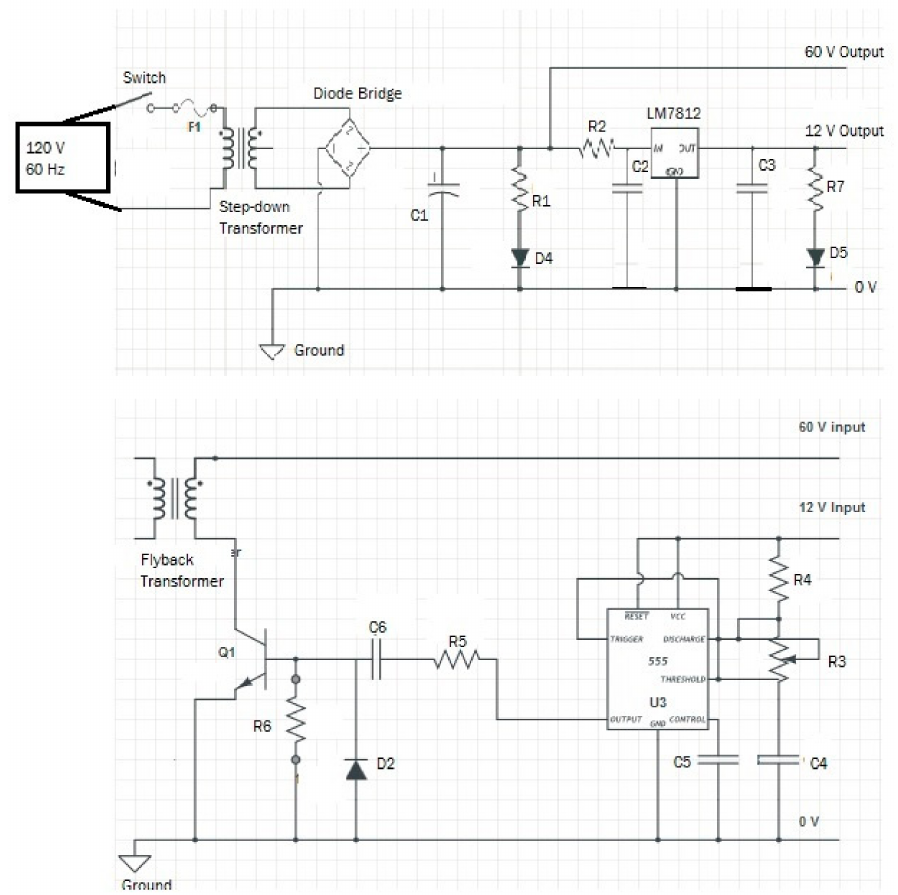
Figure 5. The diagram of the circuit being used for high voltage.